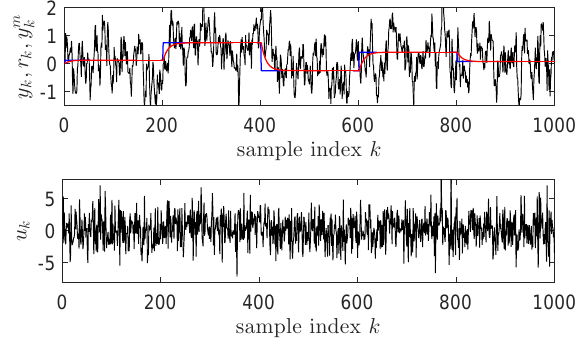
Figure 1. Closed-loop state transitions data collection for Example 1: (top) y k (black), r k (blue), y m (bottom) u k